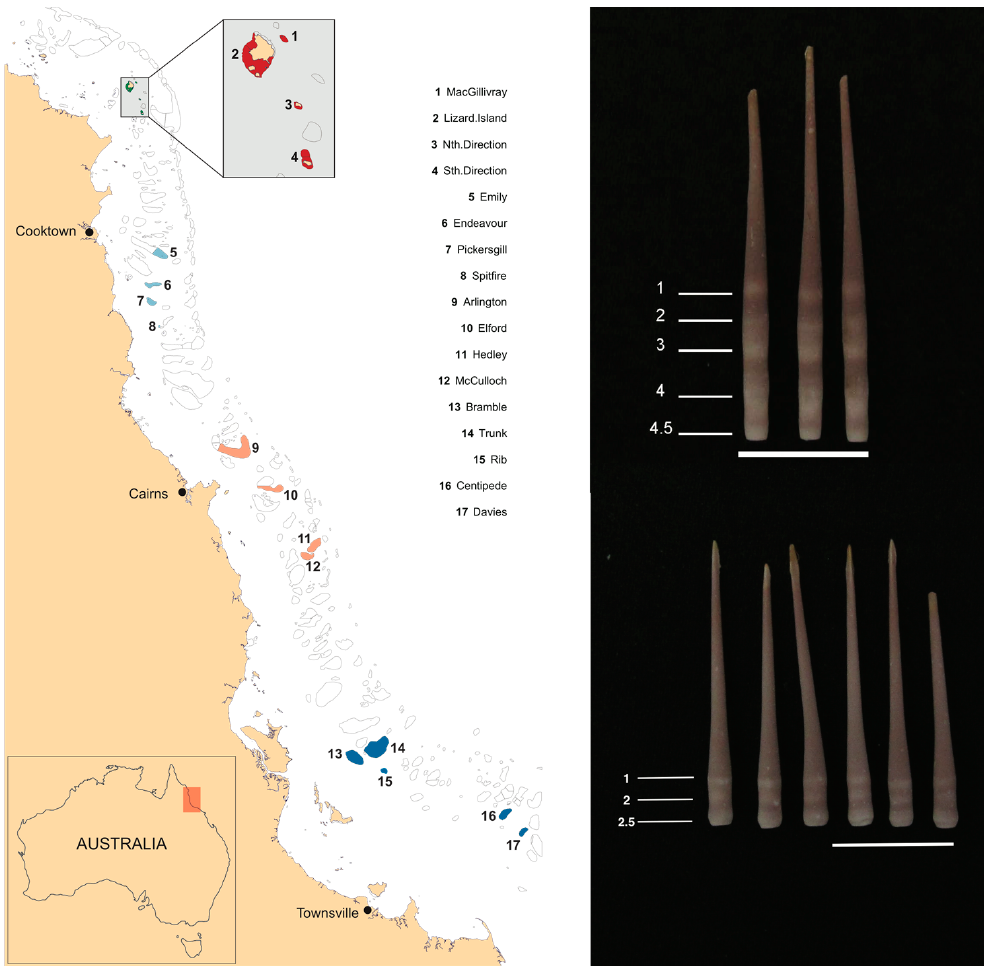
Figure 1. Great Barrier Reef study region reefs sampled for crown-of-thorns starfish (CoTS; Acanthaster spp.), October 2013 and September 2014 ( left panel ). Reefs are colored according to region. Spines selected for band counting from two starfish ( right panels ), showing distinct banding counts from 1 to 4.5 (top panel) and 1 to 2.5 (bottom panel), scale bar represents 1 cm. Table 1. Summary table of collections of crown-of-thorns starfish on the GBR between October 2013 and November 2014. Only a subset of starfish ( ≤ 202 individuals per reef) was used in demographic analyses.